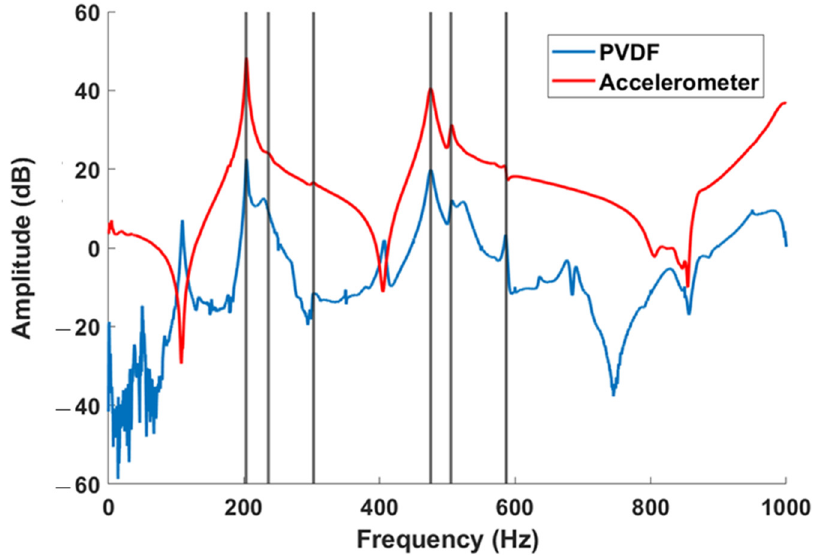
Figure 6. PVDF and accelerometer FRFs from impact hammer test; vertical lines represent some natural frequencies.